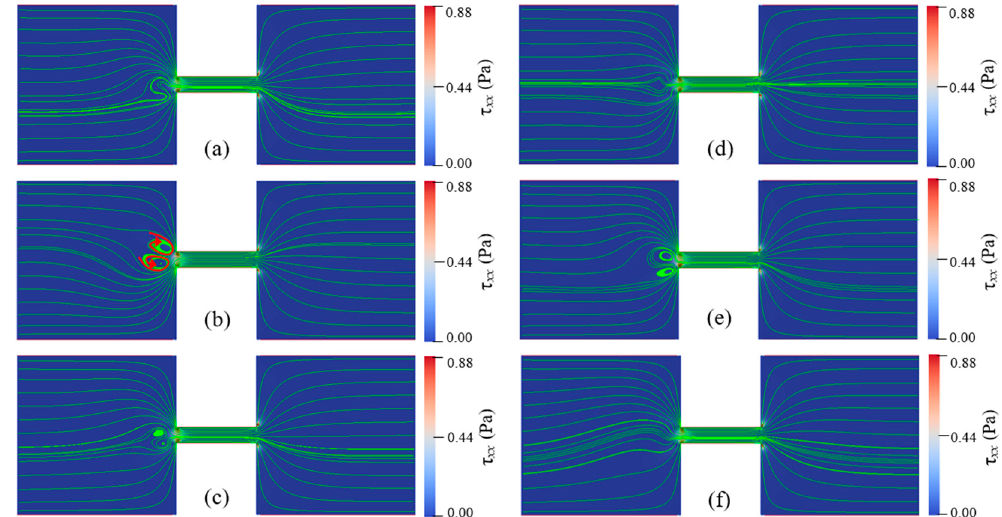
Figure 6. Instability of EOF with c p = 500 ppm and E app = 100 V/cm. Streamlines at different times: ( a ) 1.71 s, ( b ) 1.75 s, ( c ) 1.79 s, ( d ) 1.83 s, ( e ) 1.87 s, and ( f ) 1.91 s. The color bar represents the elastic normal stress τ xx . (Supplementary Video S1 ).